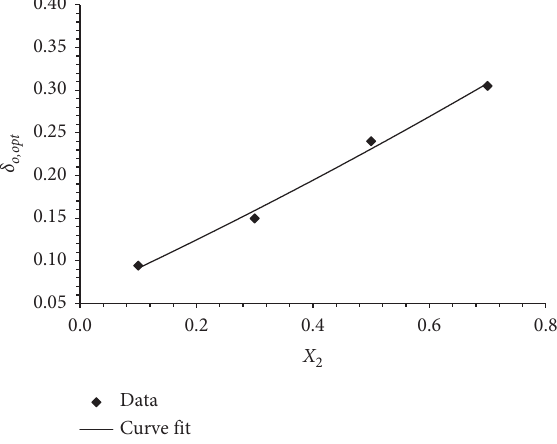
Figure 13: δ Figure 15: δ � 10, χ � 0.5. � 10, E � 0.5. o ,opt versus E for case O K r 2 o , opt versus χ 2 for case O K r Table 6: Optimum wall thickness δ Table 7: Optimum wall thickness δ o ,opt at different values of ec- o ,opt at different values of radius centricity E . ratio χ 2